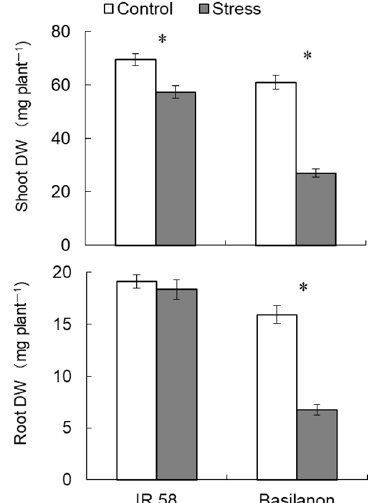
Figure 1. Shoot and root dry matter production of two rice cultivars in response to osmotic stress. Shoots and roots were sampled after 7 days (168 h) of treatment. Bars indicate the standard error (n = 12). Asterisks represent significant differences between treatments ( p < 0.05, t -test). Table 1. Effect of osmotic stress on sugar content in roots.